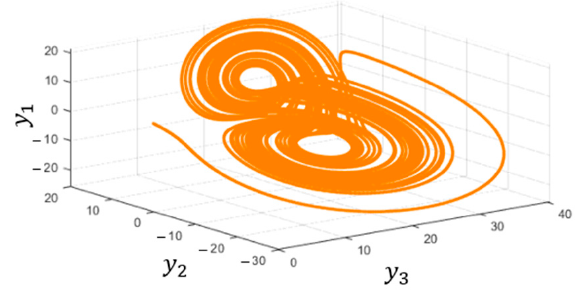
Figure 2. Strange attractor in slave.